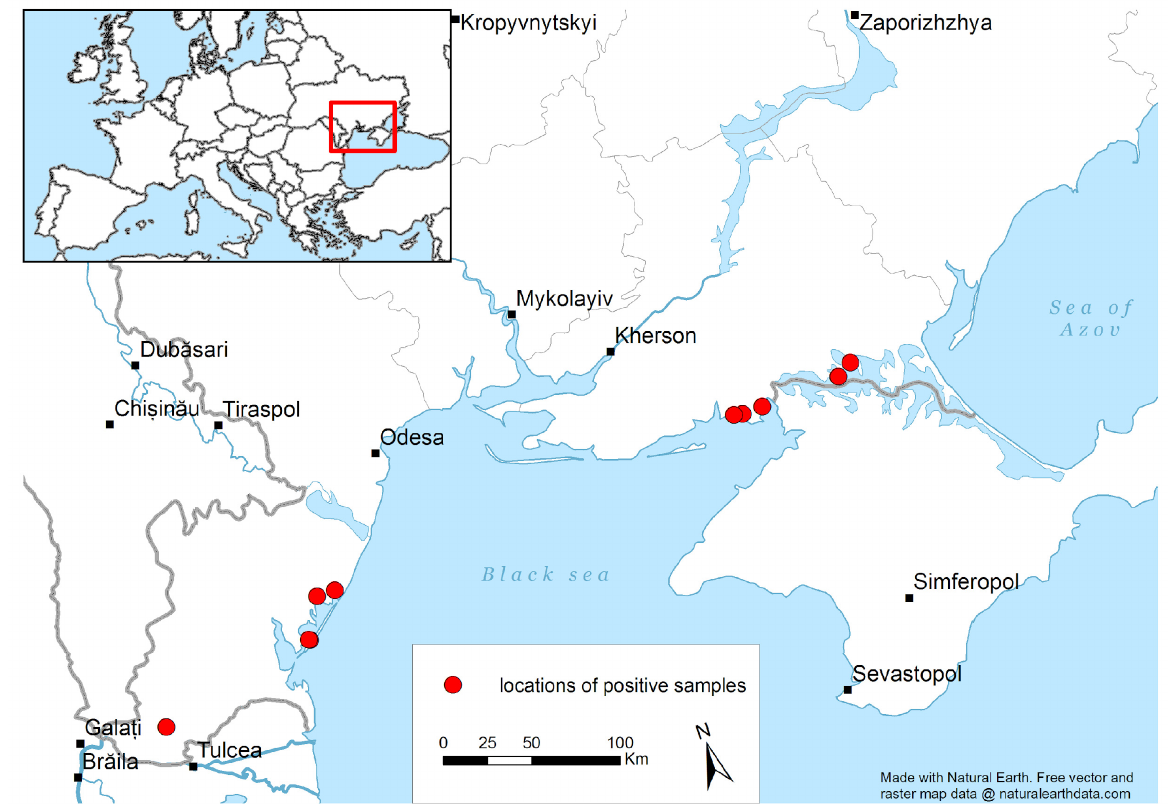
Figure 1. Map of locations of samples that were positive for avian paramyxoviruses in southern Ukraine. Environmental (feces) samples from wild birds were collected in southern Ukraine (2016–2017) in Kherson, Odesa, Mykolaiv, and Zaporizhzhya Oblasts . Locations where samples tested positive for avian paramyxoviruses by diagnostic RT-PCR are indicated ( • ). Positive wild bird samples were found in proximity to brackish or salt water liman and Sivash (bays) in Kherson Oblast near Crimea and in proximity to Sasyk L(lagoons) and the Danube River Delta region in southern Odesa Oblast . Samples were collected in cryotubes containing 1.0 mL of viral transport media (BHI, Brain Heart Infusion broth, Sigma-Aldrich, #53286-100G) with antibiotics (penicillin 10,000 U/mL, streptomycin 10 mg/mL, gentamicin 250 µ g/mL, and nystatin 5000